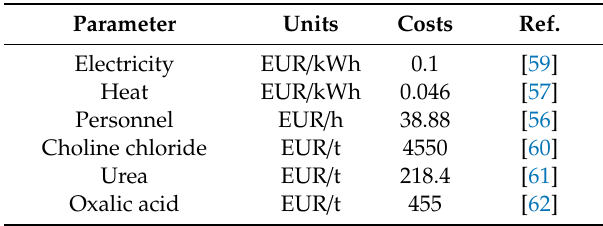
Table 3. Parameters for operation